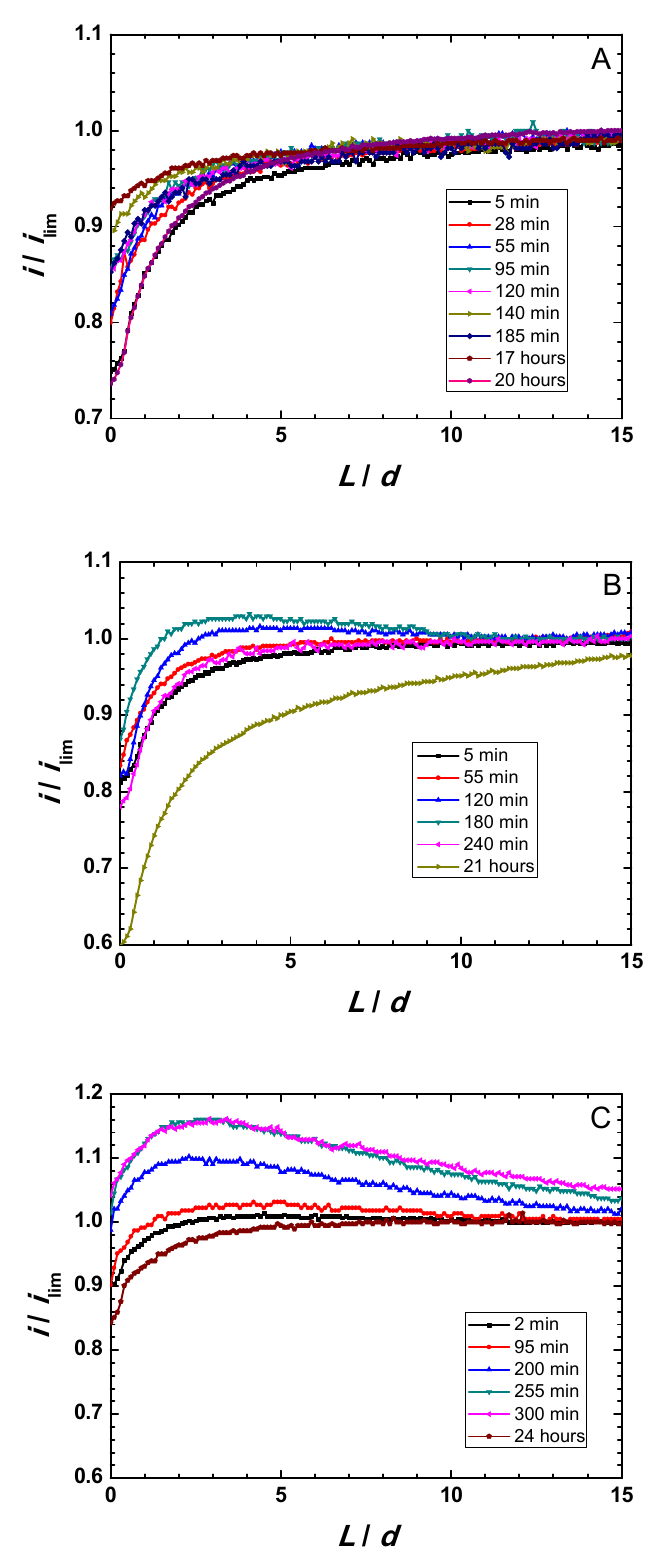
Figure 4. Feedback mode Z-approach curves on oxidized binary Zr-Ti alloys immersed in acidified Ringer’s solution at 37 °C. ( A ) Zr-5Ti; ( B ) Zr-25Ti; ( C ) Zr-45Ti.